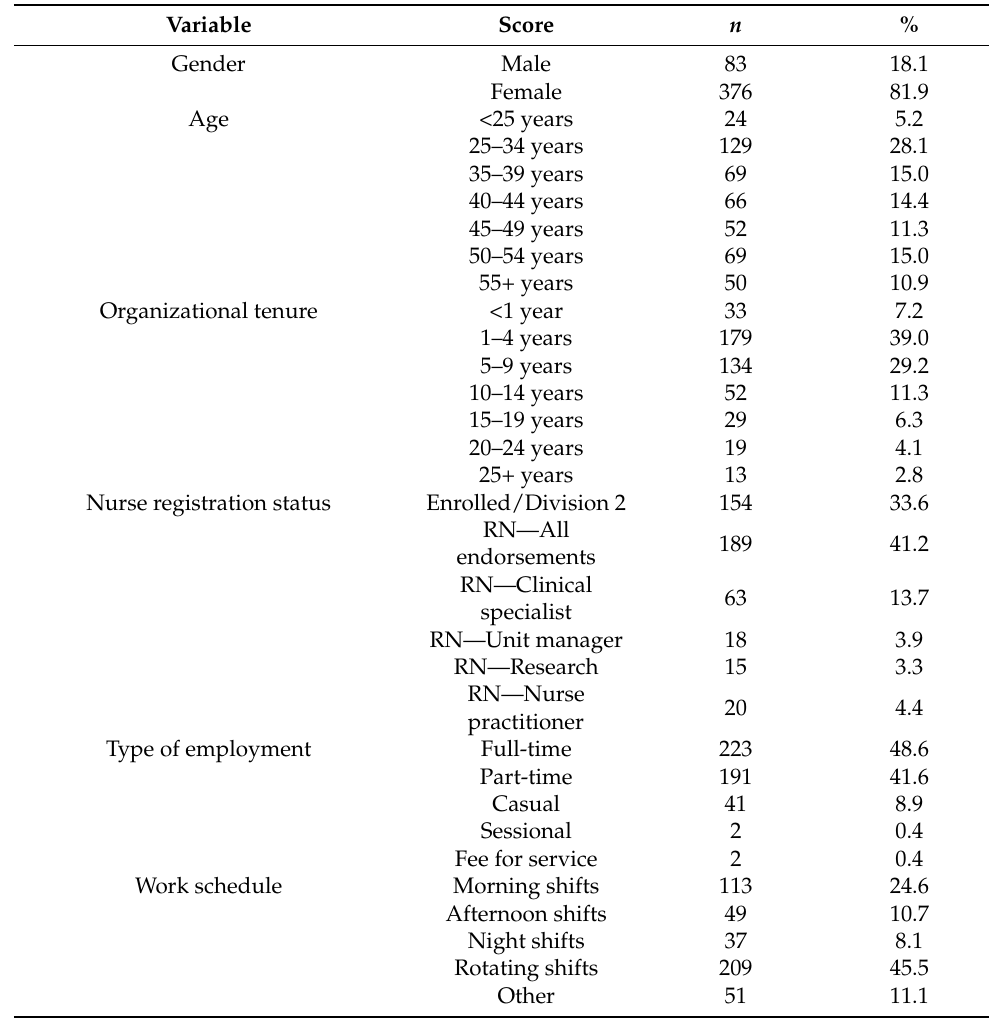
Table 1. Characteristics of the